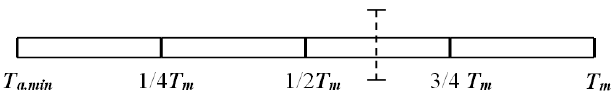
Fig. 1. The expert survey about the reasonable time for calculating the mathematical models of the energy consumption of appropriate technological equipment.